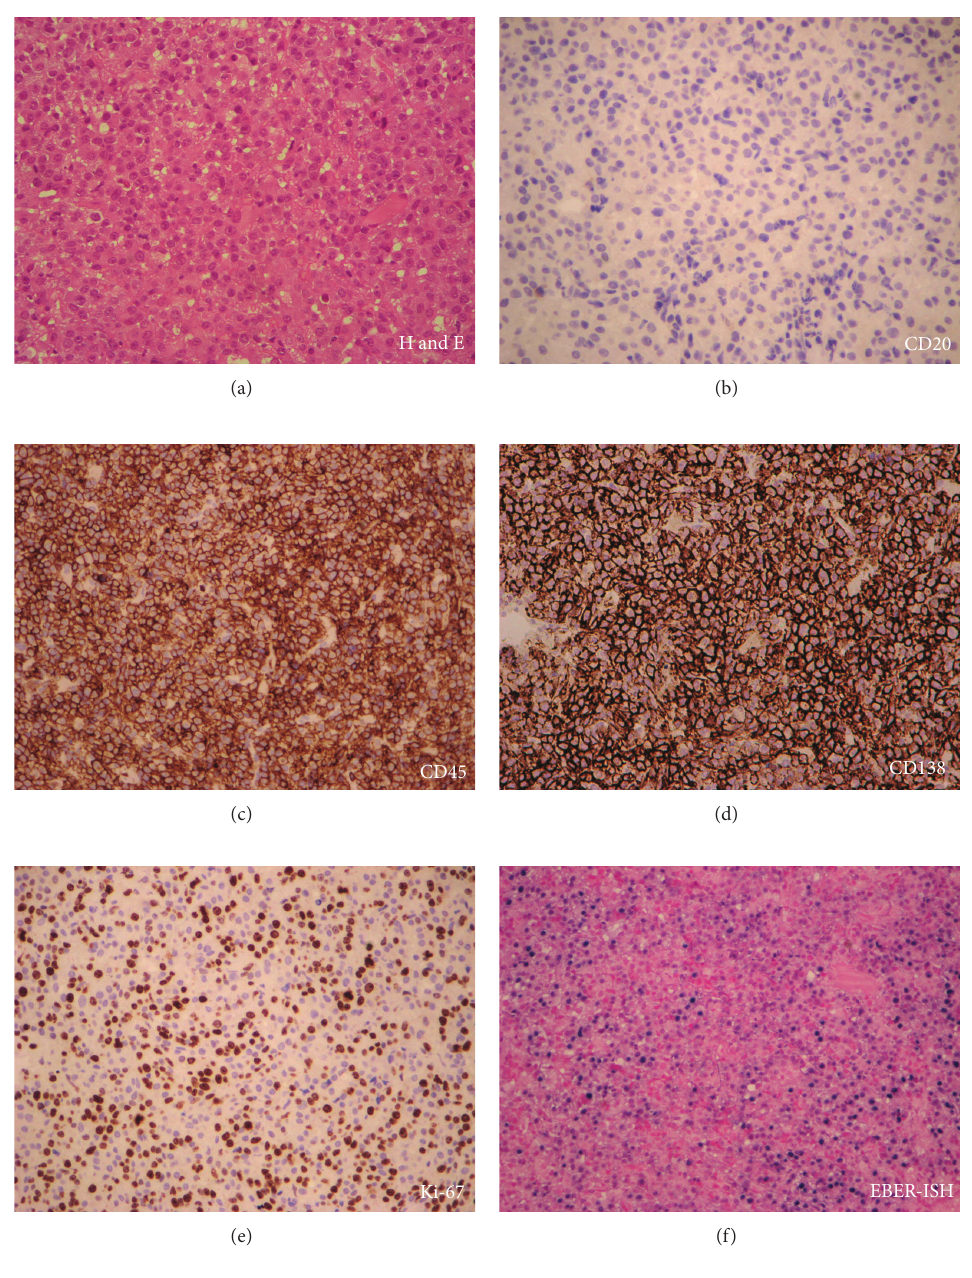
Figure 2: Punch biopsy of the left